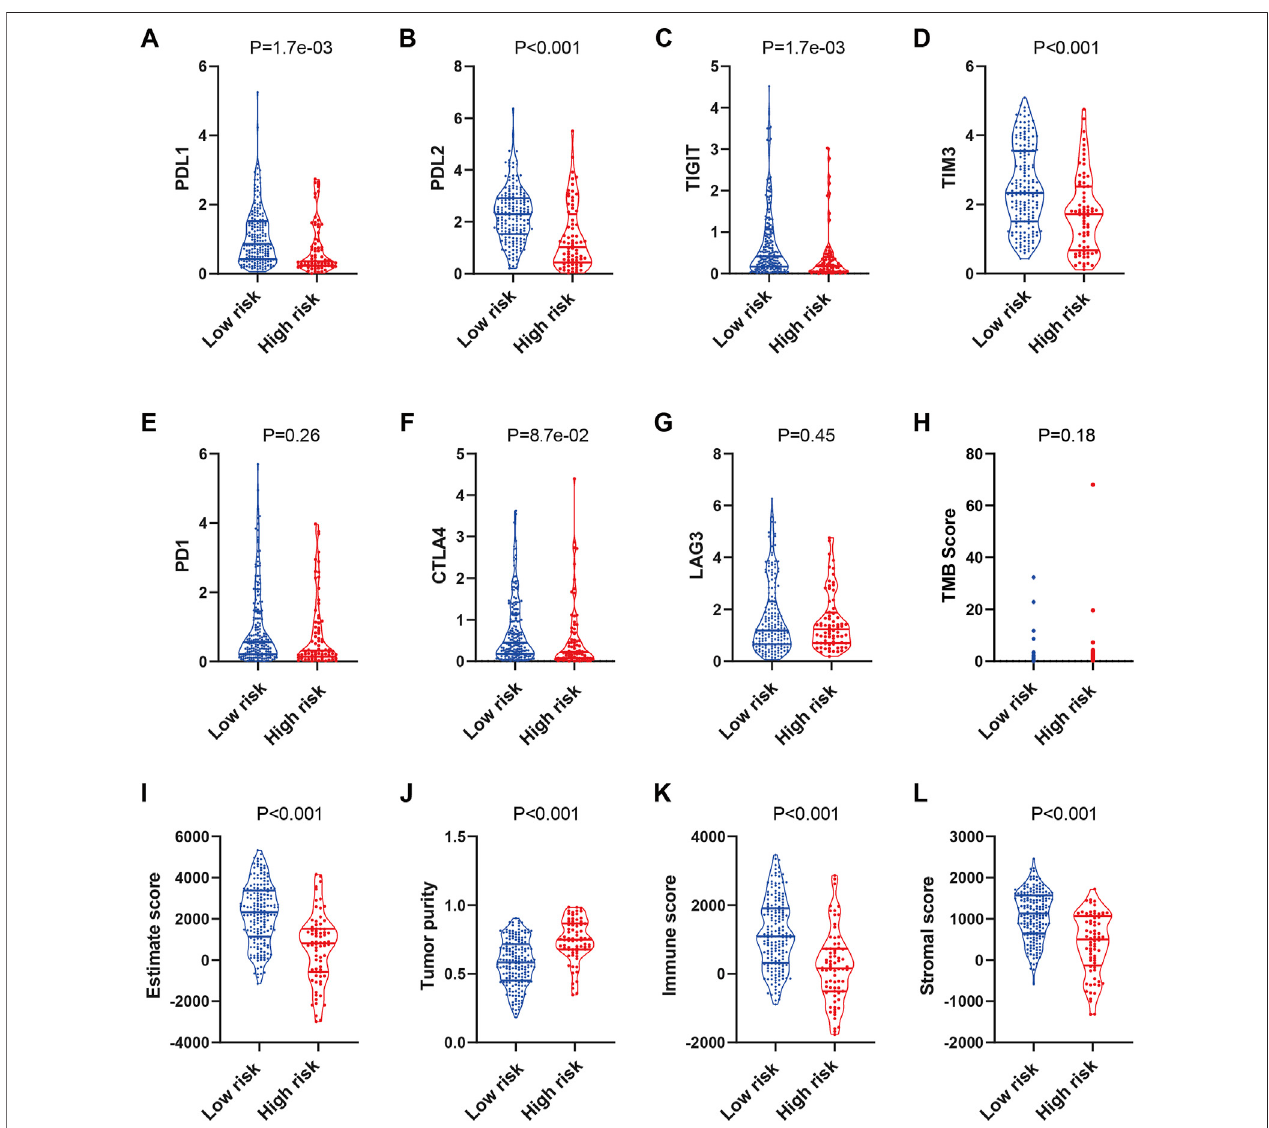
FIGURE 5 | Prediction of the immunotherapy response in TCGA-SARC patients. The expression of PDL1 (A) , PDL2 (B) , TIGIT (C) , TIM3 (D) , PD1 (E) , CTLA4 (F) , LAG3 (G) and distribution of TMB (H) score in low and high risk groups. Estimation of STromal and Immune cells in MAlignant Tumours using Expression data (ESTIMATE) analyses of TCGA-SARC (I – L) . TCGA, The Cancer Genome Atlas; TCGA-SARC, the whole TCGA sarcoma cohort.